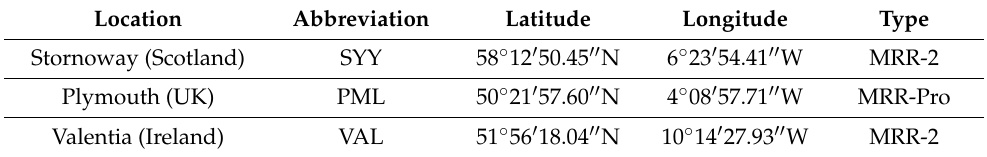
Table 1. MRR locations used in this